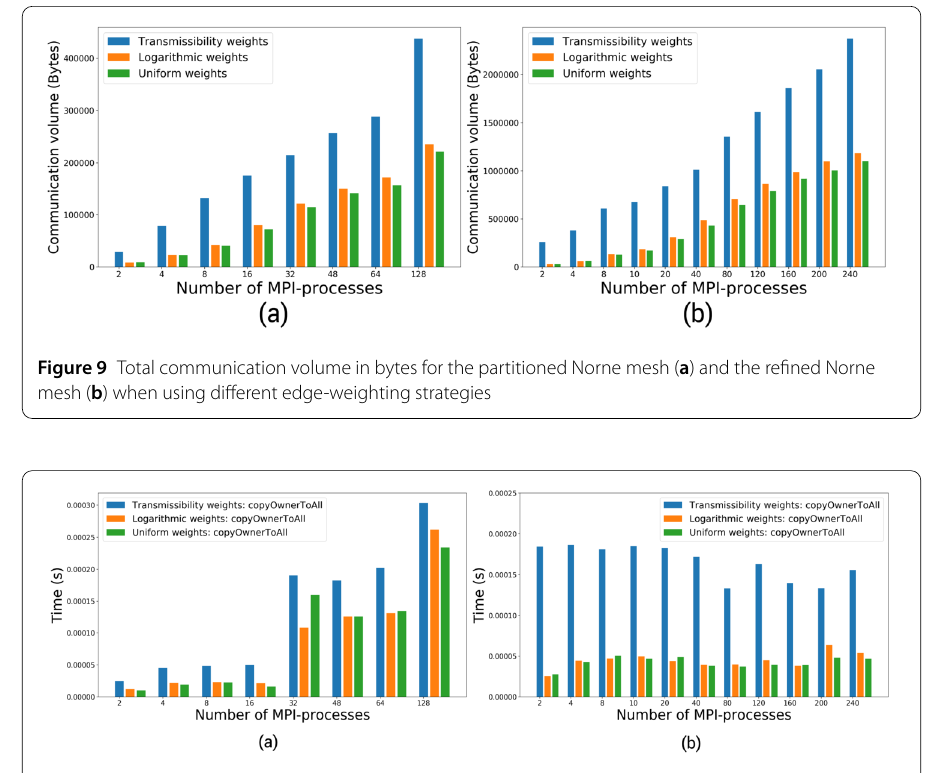
Figure 10 Communication overhead, i.e., time usage of DUNE’s copyOwnerToAll function on the Abel ( a ) and Saga ( b ) clusters. Multiple computational nodes are used when the number of MPI-processes exceeded 16 on Abel ( a ) and 40 on Saga ( b